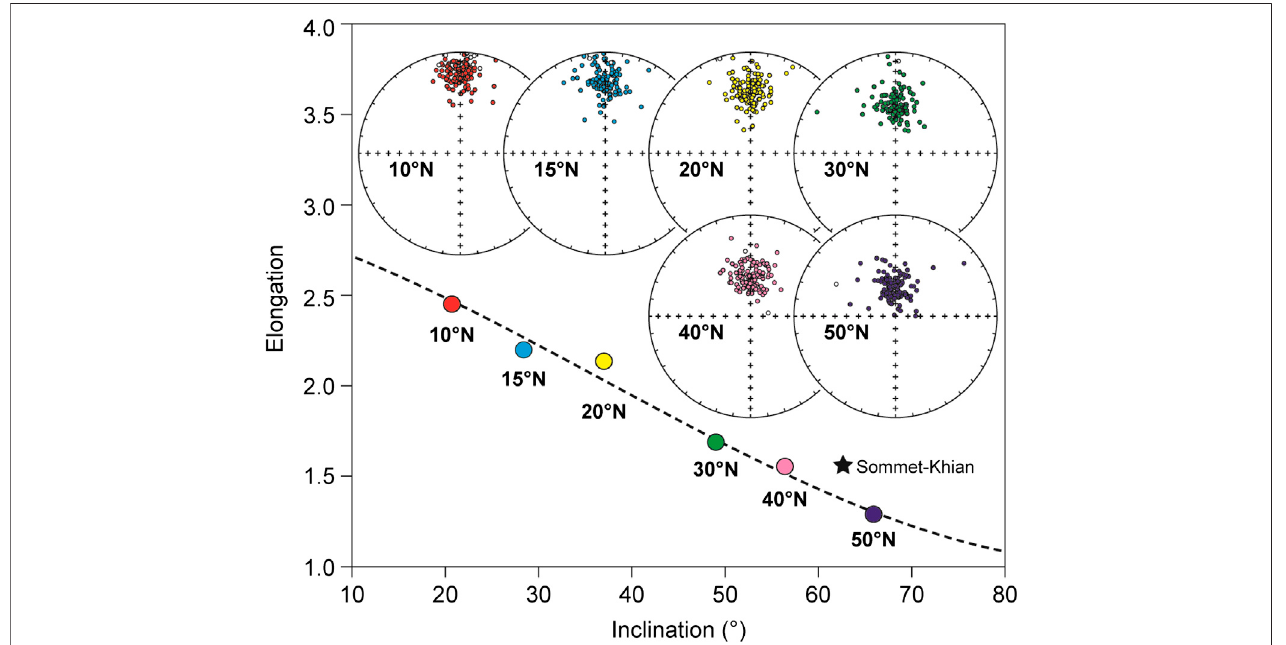
FIGURE3| Simulated setsofpaleomagneticdirectionspredicted bytheTK03.GADpaleosecularvariationmodel.Eachstereographicprojectionisshownwiththe associated latitude. Theelongation/inclination(E/I) values predicted bythe TK03.GAD model are shown bythe dashed line,togetherwith the E/I pair ofeach distribution (the colorcorresponds to the associated stereographic projection). The star isthe E/I pair ofthe paleomagnetic directions set from Sommet-Khian discussed inthe text.